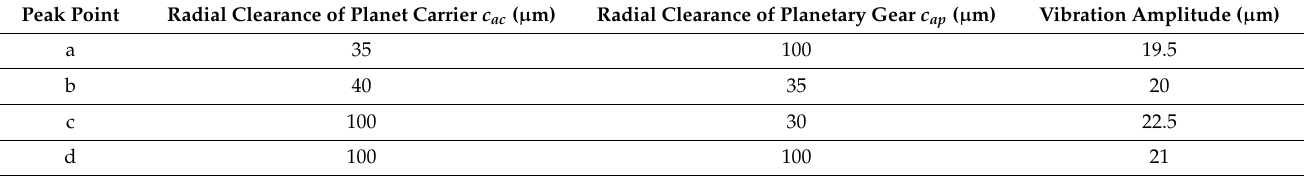
Table 5. The peak value radial vibration for antenna reflector in Figure 9b. Peak Point